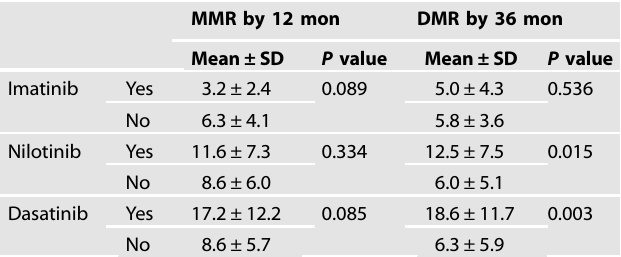
Table 2. Percentage of IFN γ + naïve γδ T cells (Mean ± SD) in CML patients treated with TKIs.